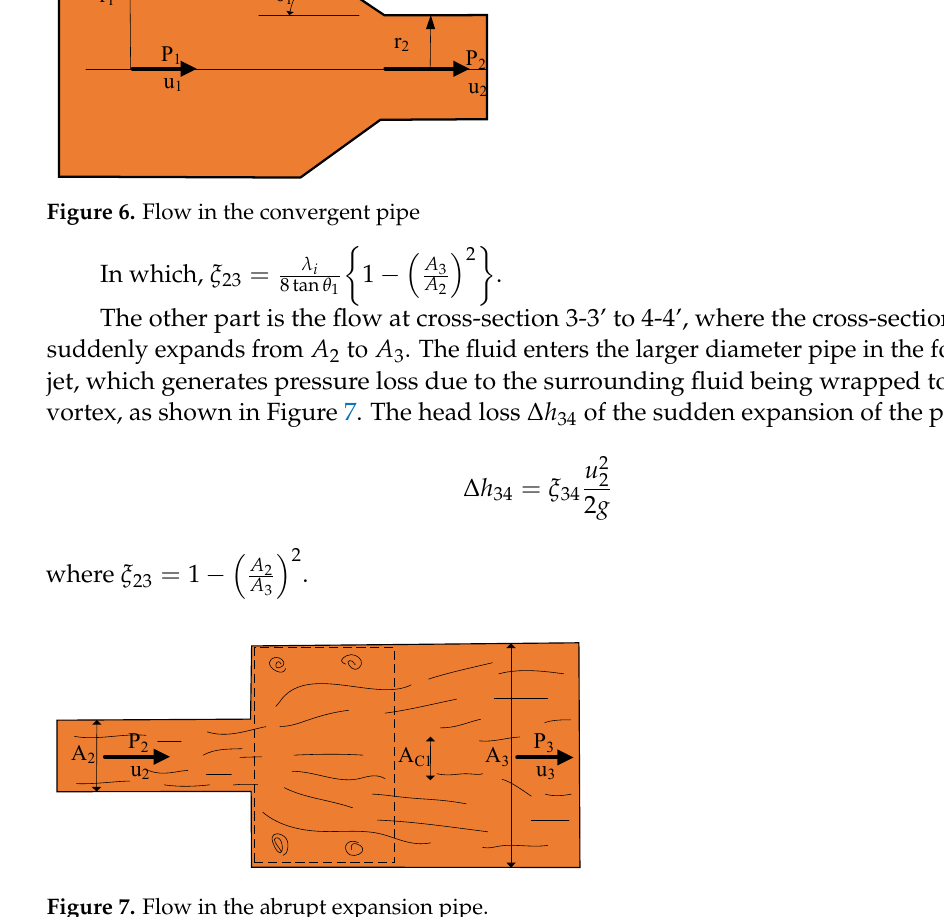
Figure 7. Flow in the abrupt expansion pipe.